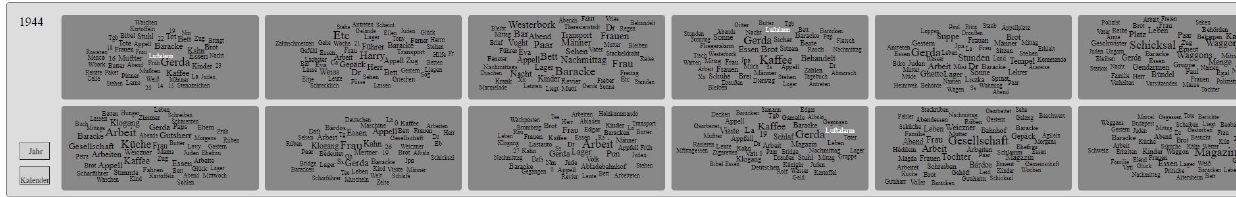
Figure 5. Tag clouds are linked together. Hovering over a tag in one cloud highlights all other occurrences in the other clouds. In this example, the term “Luftalarm” German for “air raid warning” was found in three different months of